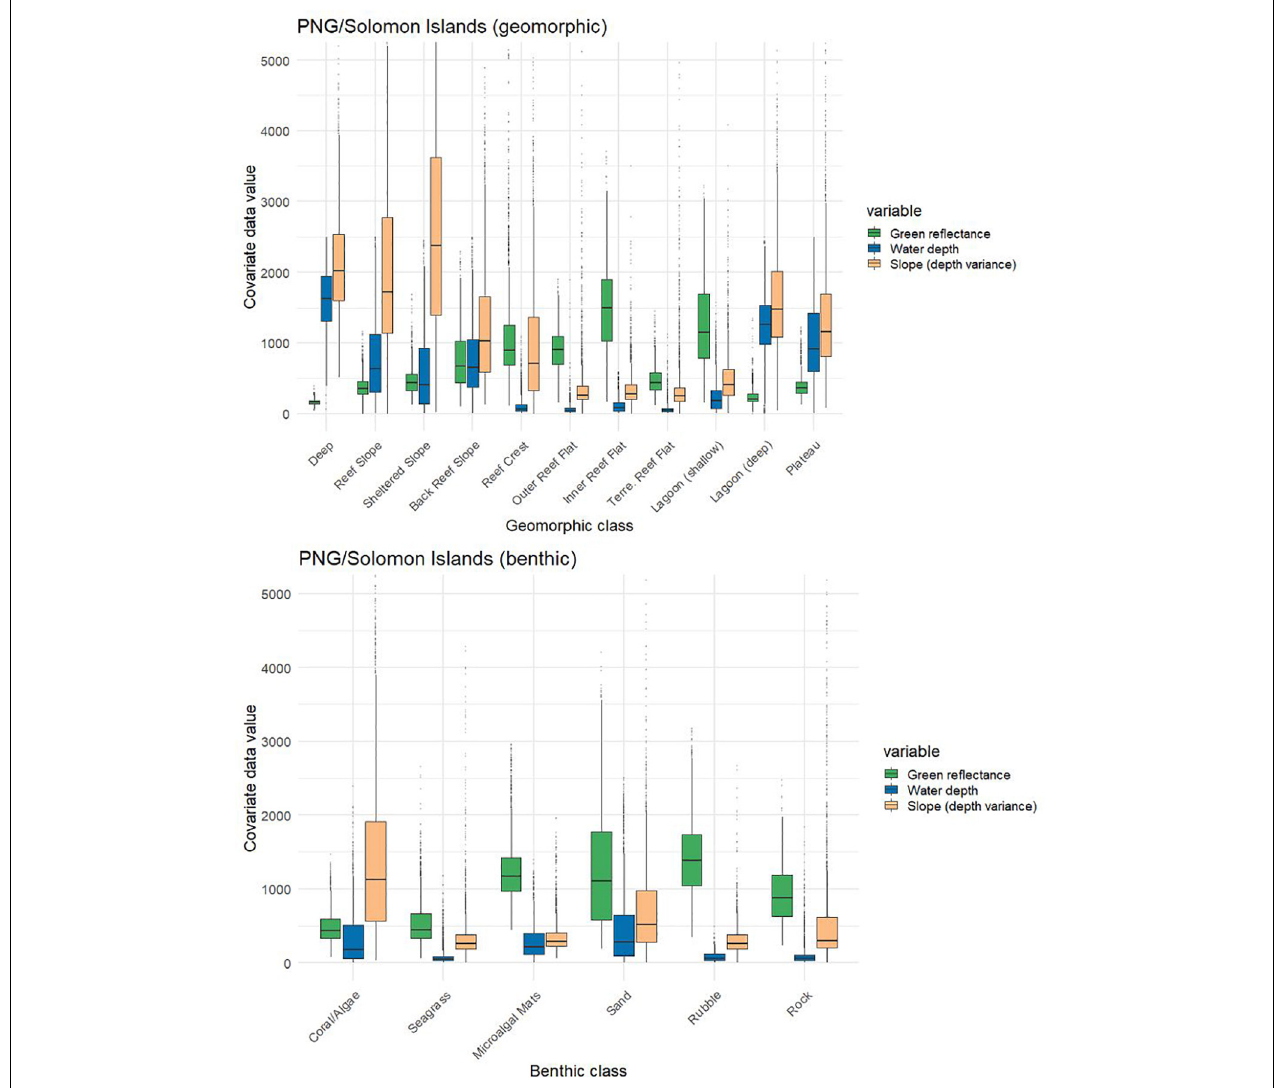
FIGURE 7 | Example of mean covariate values [green band reflectance, water depth, slope (stdevDepth)] for each of the mapping classes for geomorphic and benthic maps, highlighting the variability of the PNG-Solomon Islands